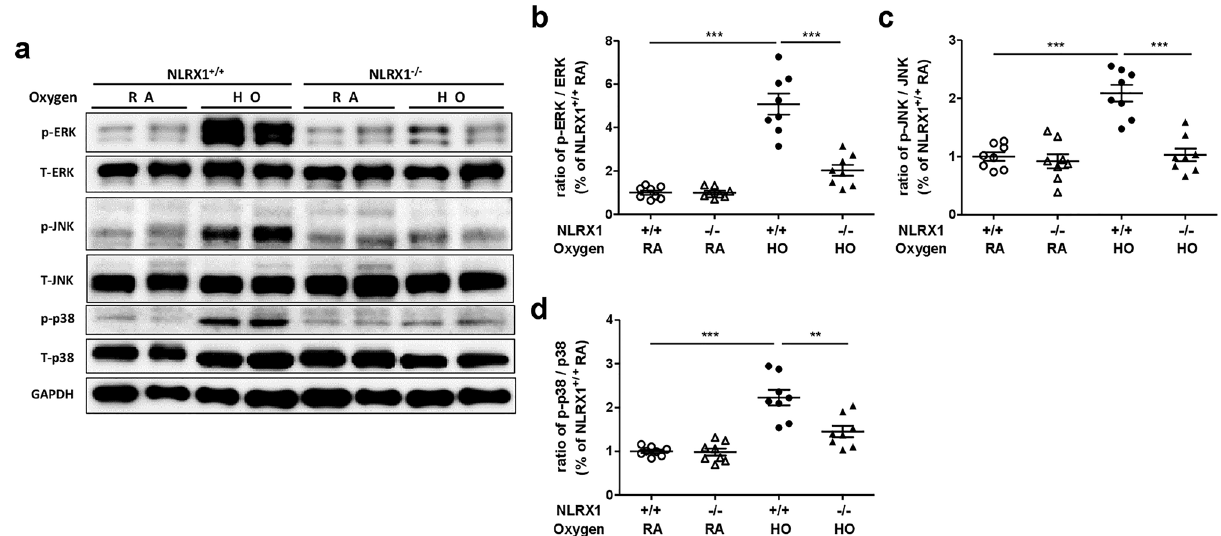
Figure 5. NLRX1 regulates MAPK signaling pathways in hyperoxia. ( A ) Phosphorylation of MAPK pathways (ERK 1/2, JNK, and p38) was measured by western blot analysis using lung lysates, and ( B – D ) the ratios